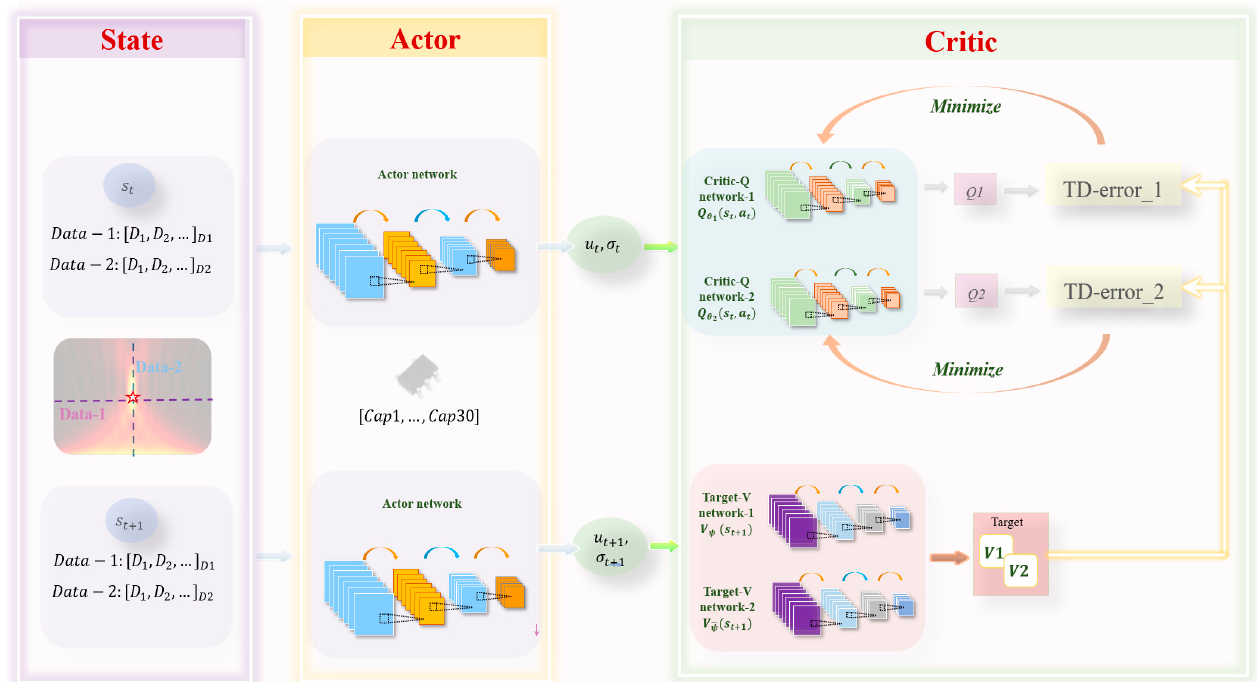
Figure 2. Architecture of SAC. State ( s t ) is the data of the focal plane, and the action is the capacitance sequence: [ Cap 1, . . . , Cap 30 ] . SAC network consists of one actor network and four critic net- works (Q-network-1, Q-network-2, V-network-1, and V-network-2).